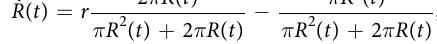
of the confined st